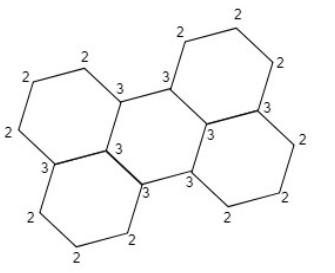
Figure 1. Vertices degree of the perylene benzenoid graph ( P ).